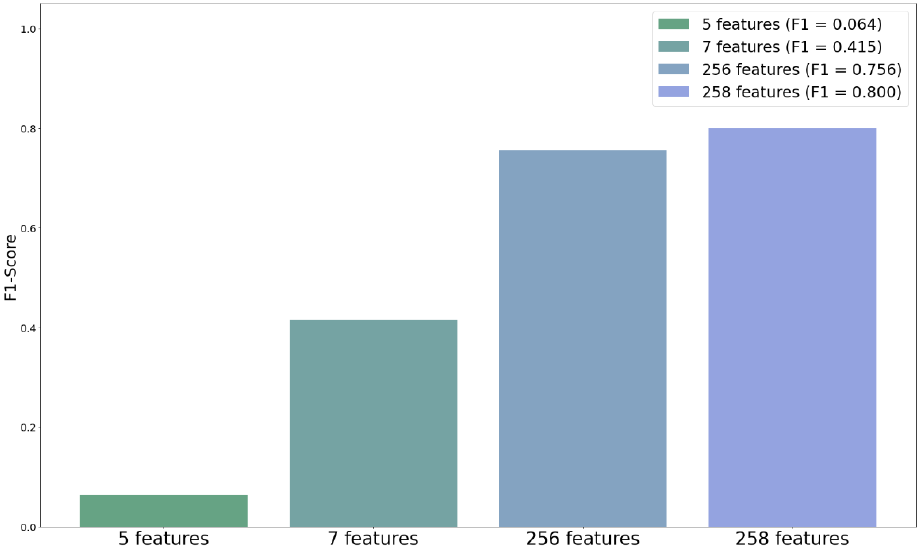
Figure 5. F1-score comparison of adding metadata.